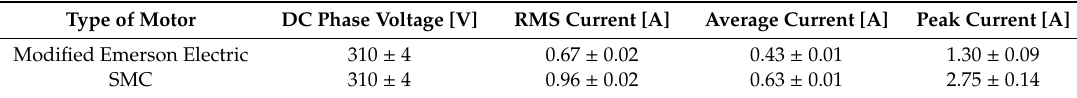
Table 2. Phase supply currents for modified Emerson Electric and SMC motors, for T = 0.35 Nm, n = 4400